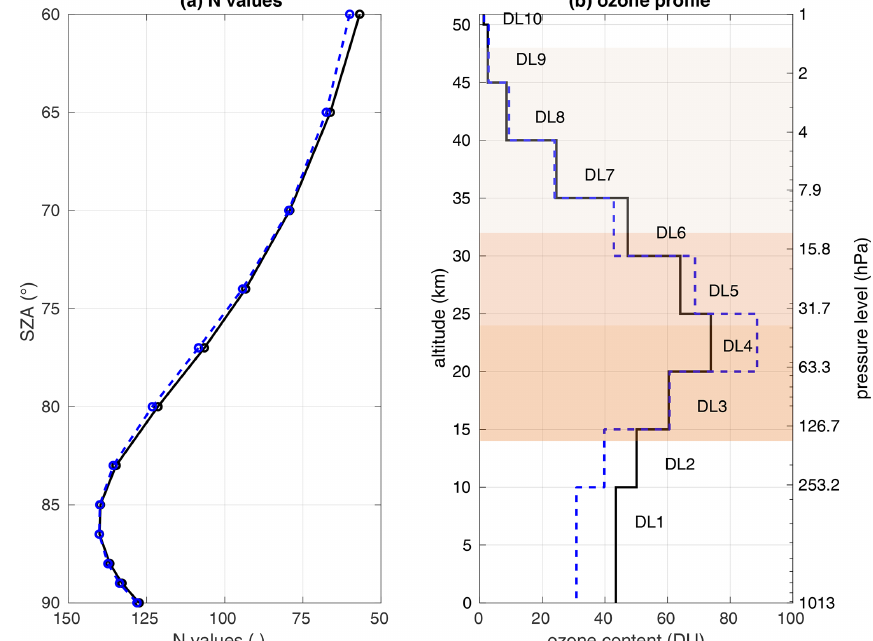
Figure 1. (a) Morning (in black) and afternoon (in blue) N curves at 12 nominal SZAs and (b) their corresponding retrieved ozone profiles in Dobson units (DU) as a function of altitude in kilometers and pressure level in hectopascals (hPa). Total column ozone and atmospheric conditions slightly differ between the morning and the afternoon. The altitude ranges of the 10 Dobson layers (DLs) are shown in (b) . Lower, middle and upper stratospheric ranges are displayed by beige